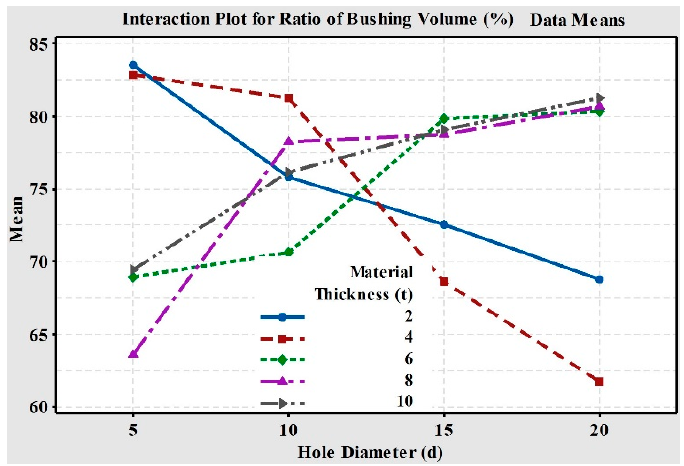
Figure 10. The interaction plot of the hole diameter and volume ratio of the bushing.